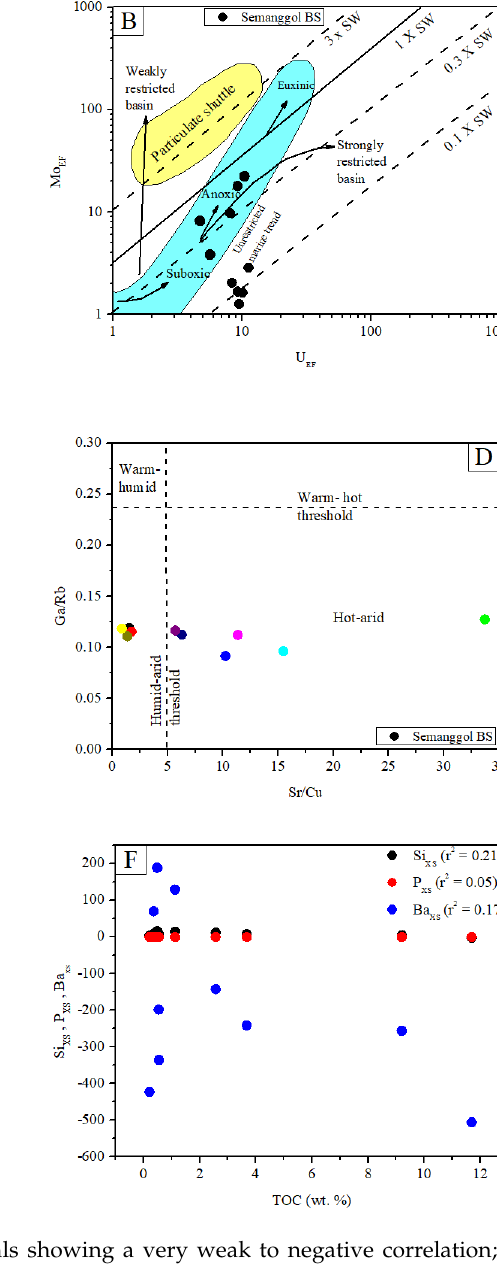
Figure 9. (A ) Cross-plot of TOC vs. redox metals showing a very weak to negative correlation; ( B ) Cross-plot of the enrichment factor of Mo EF against U EF . The lines display Mo / U ratios equal to seawater (SW). The patterns of U EF and Mo EF are compared to the model of Algeo and Tribovillard [83]; ( C ) Correlation of TOC against U EF and Mo EF showing a moderate positive correlation; ( D ) Ratios of Sr / Cu vs. Ga / Rb illustrating climatic conditions in the Semanggol Basin during Triassic black shale deposition; ( E ) Graph bar showing the concentrations of Ba bio and Ba terr in the black shale sample; ( F ) Plot of TOC content vs. Ba xs , P xs , and Si xs showing a weak to moderate positive correlation with paleoproductivity indicators.